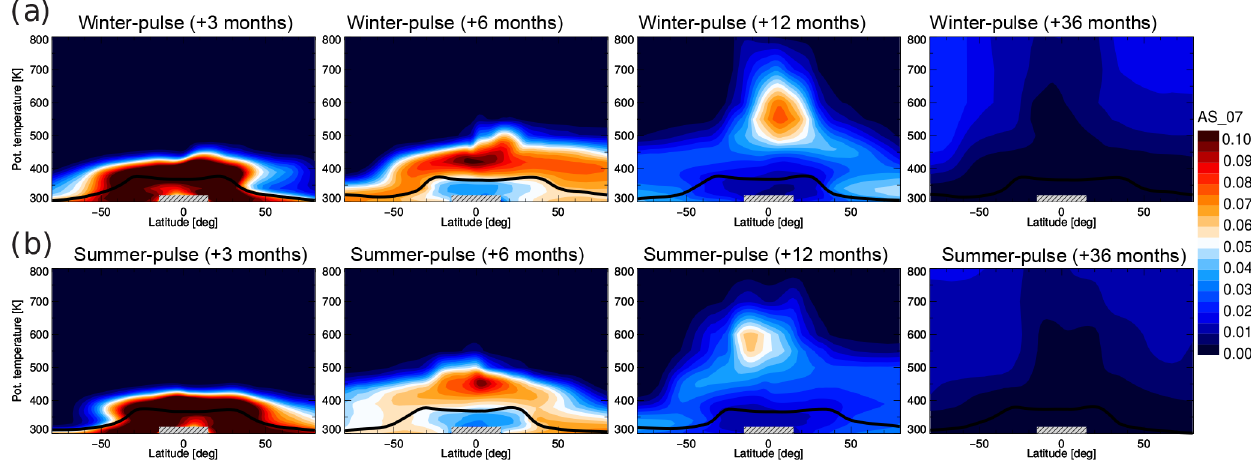
Figure 2. Evolution of tracer pulses released in the tropical boundary layer during NH winter (a) and summer (b) during the following months (3, 6, 12, 36 months after pulse release). The winter pulse was released during January 2000, the summer pulse during July 2000. The black line shows the climatological tropopause, the grey hatched line at the tropical surface the pulse release